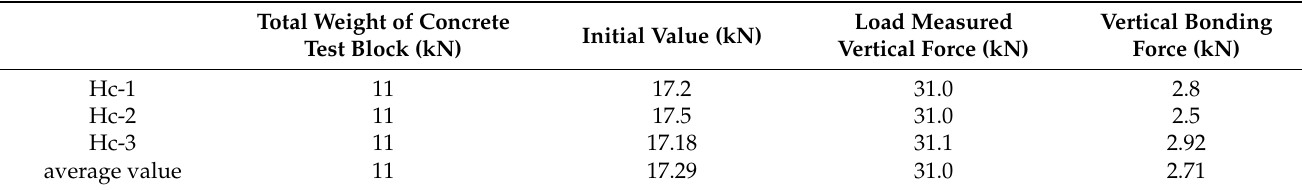
Table 5. The vertical force of the specimen with the contact surface of ordinary